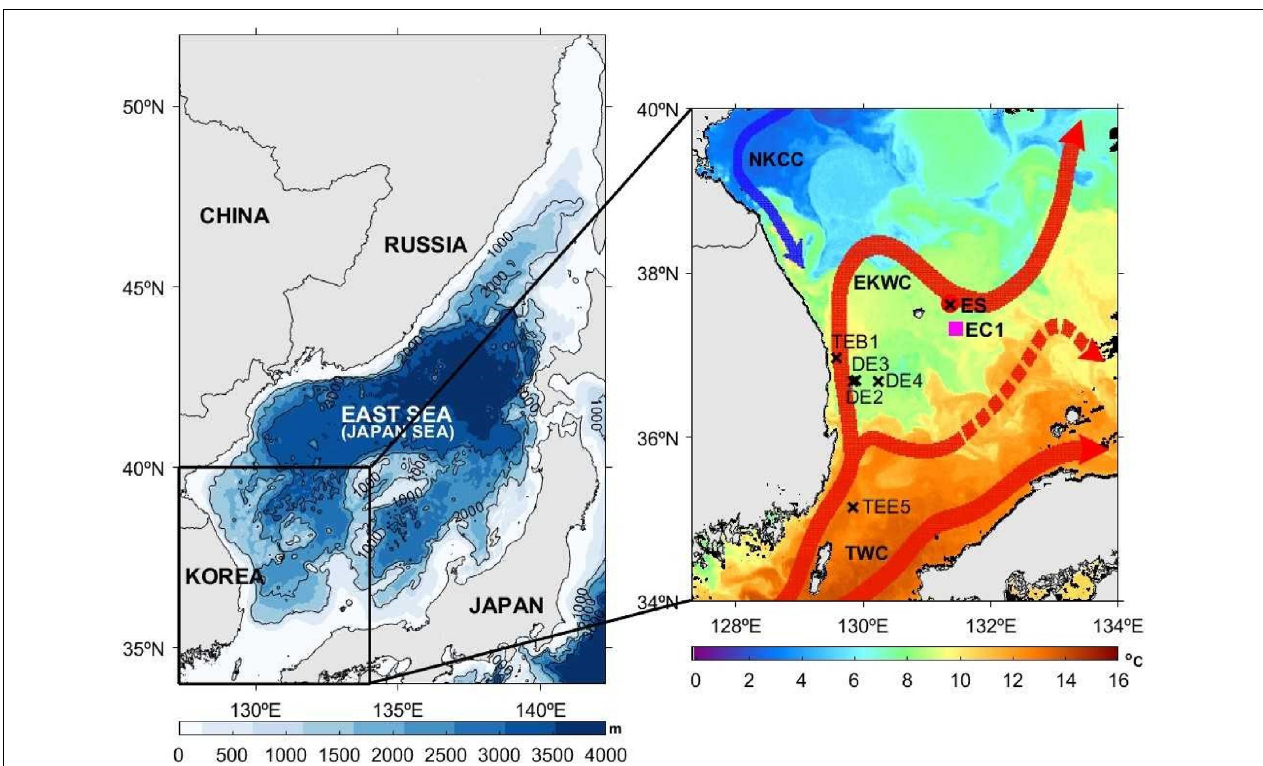
FIGURE 1 | Bathymetry (left panel) of the East Sea (Japan Sea) and the sea surface temperature ( right panel , the image was taken by satellite NOAA-19 on 30 March, 2011). The locations of the mooring sites, ES and EC1, and the surface sediment sampling sites are indicated (X marks). A schematic of major surface currents is also shown (NKCC: North Korea Cold Current, EKWC: East Korea Warm Current, TWC: Tsushima Warm